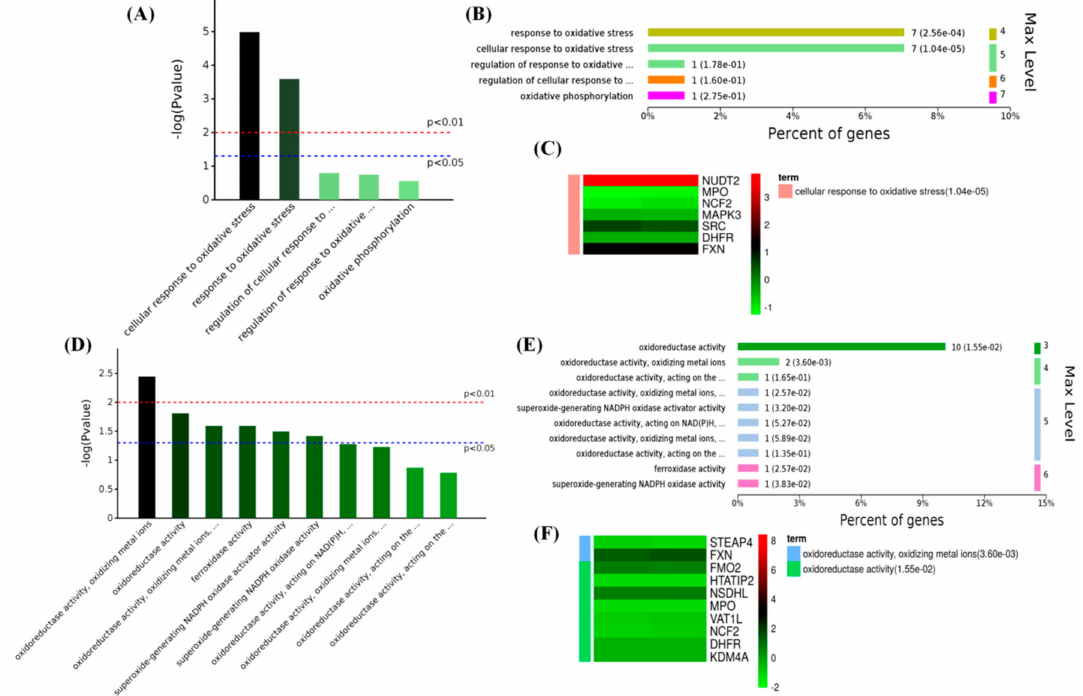
Figure 6. Enriched GO of 119 differential proteins in oxidative stress-related terms. ( A ) Oxidative stress-related biological process terms with p -values; ( B ) significantly enriched biological processes of oxidative stress (high-melatonin-level goats vs wild-type (WT) goats); ( C ) expression of oxidative stress-related proteins in biological process terms: red: upregulation; green: downregulation (high-melatonin-level goats vs WT goats); ( D ) oxidative stress-related molecular function terms; ( E ) significantly enriched molecular function of oxidative stress (high-melatonin-level goats vs WT goats); ( F ) expression of oxidative stress-related proteins in molecular function terms: red: upregulation; green: downregulation (high-melatonin-level goats vs WT